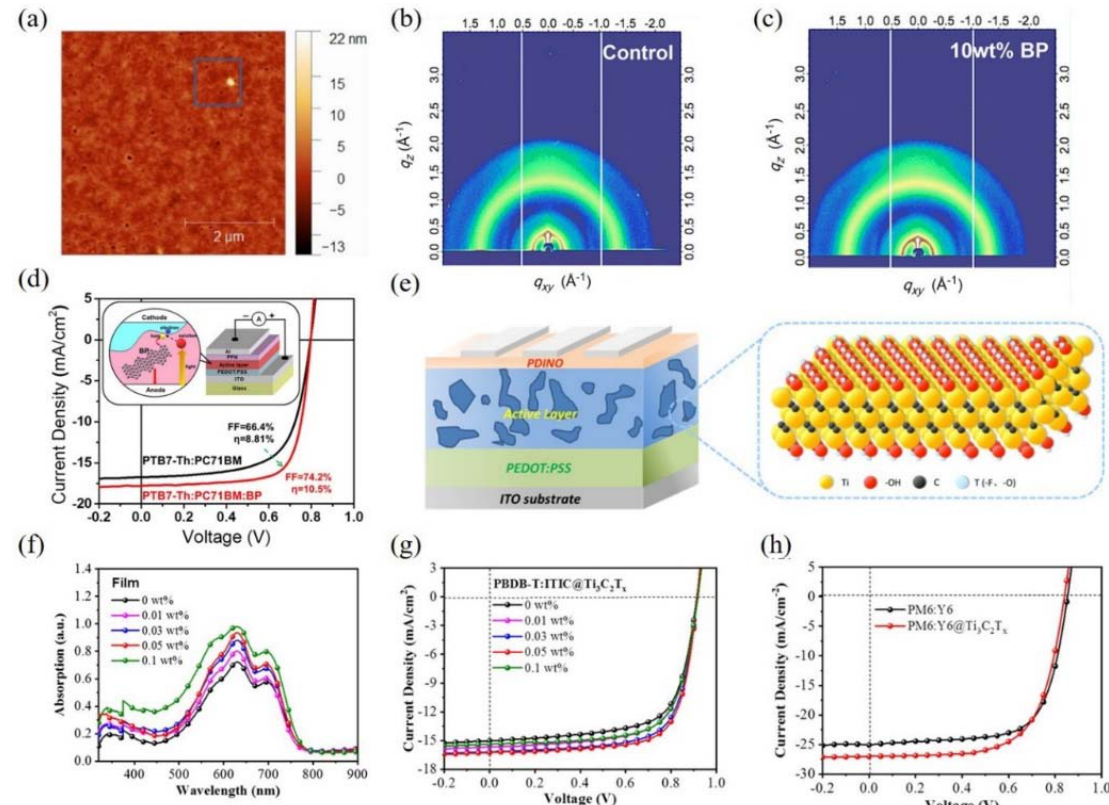
Figure 4. ( a ) AFM height images for PTB7-Th:PC 71 BM:BP blend film; 2D GIWAXS patterns of PTB7-Th:PC 71 BM:BP blend films with various concentration of BP: ( b ) 0 wt% and ( c ) 10 wt%; ( d ) J-V curves of a reference device and the best OSCs with the addition of BP. Inset: The structure of devices and the schematic diagram of light absorption, exciton migration, and separation; ( e ) The structure of OSCs and the schematic structure of Ti 3 C 2 T x ; ( f ) UV-vis absorption spectra of PBDB-T:ITIC doped with different concentration of Ti 3 C 2 T x , and ( g ) the related J-V curves of the corresponding OSCs; ( h ) The optimal J-V curves of PM6:Y6@Ti 3 C 2 T x (0.05 wt%)-based devices. Reprinted with permission form [67,79]. Copyright 2018 Elsevier Ltd. and 2021 John Wiley and Sons. Table 2. 2D layer materials incorporated into the active layer of the OSC with PCE over 7%.